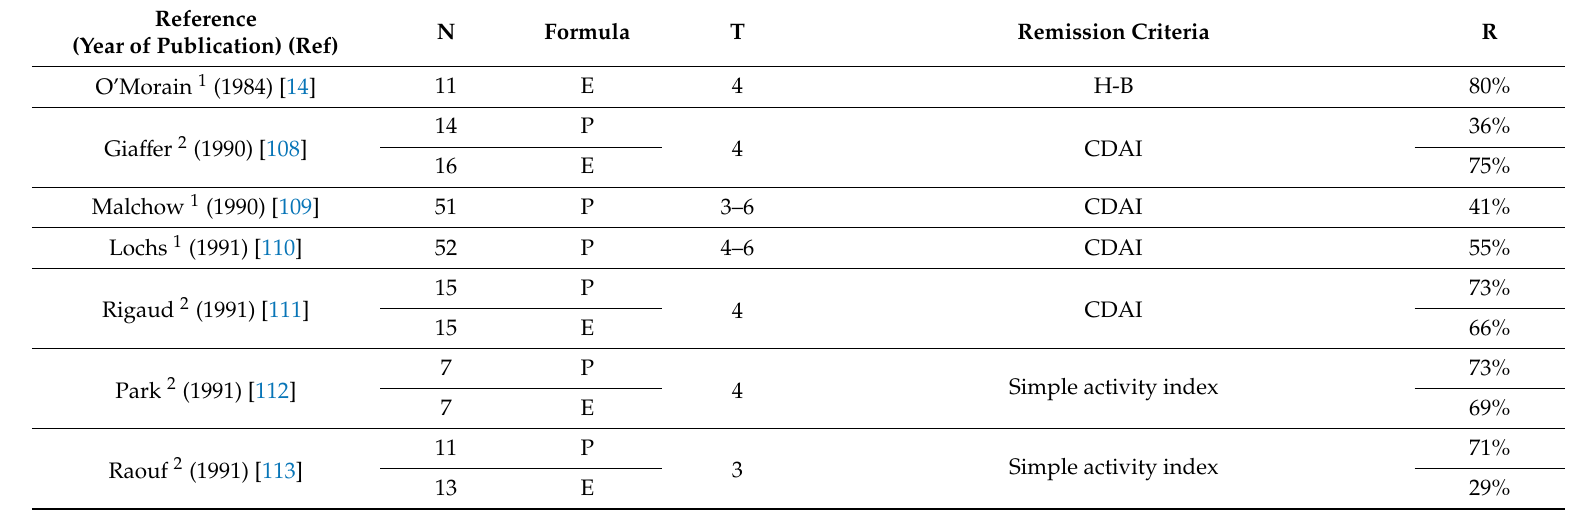
Table 4. Clinical remission rates in adults with CD treated with